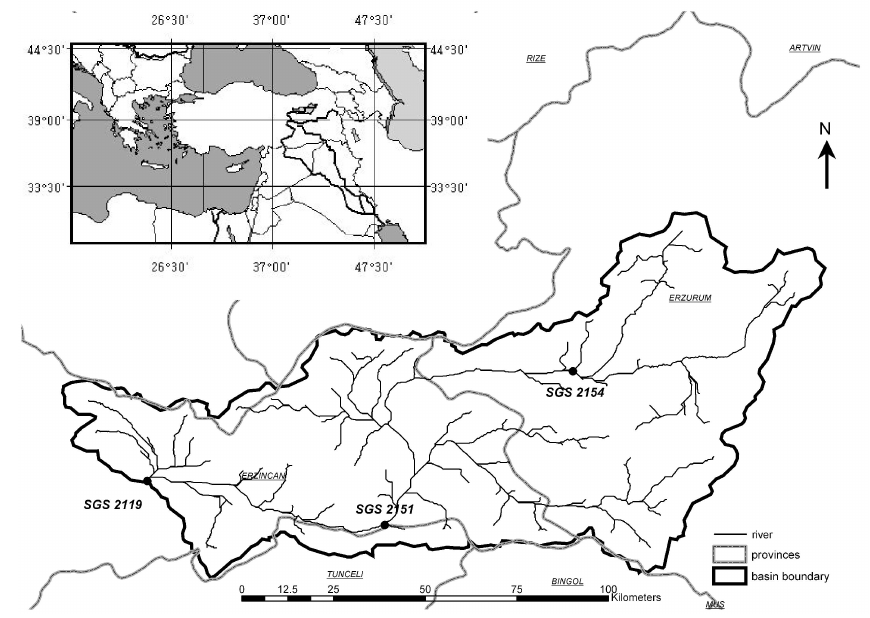
Fig. 1. Location of Karasu Basin (upper Euphrates River) in Turkey and stream gauging stations (SGS) in the basin.